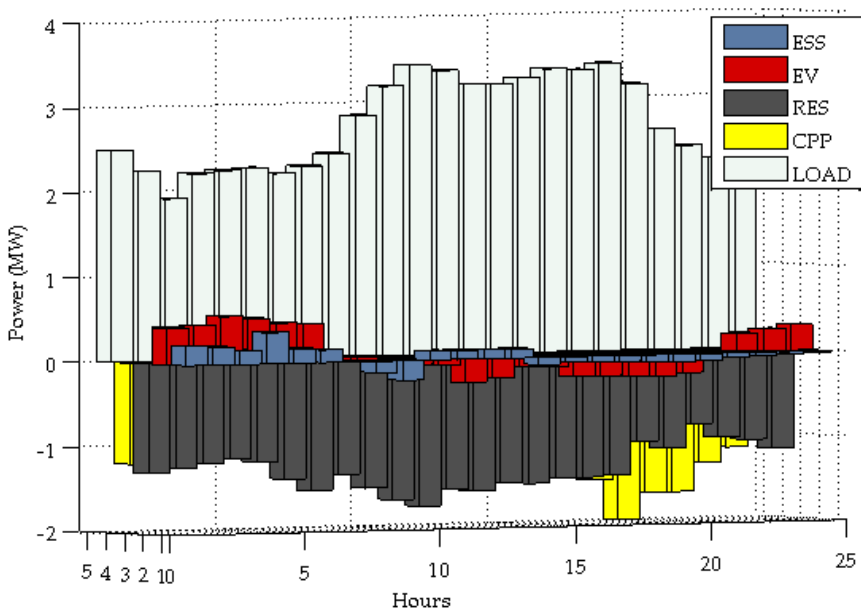
Figure 8. Network operational strategy in supplying electrical demand (scenario 8). Table 9. The contribution of each resource in supplying total 24-hour electrical demand.